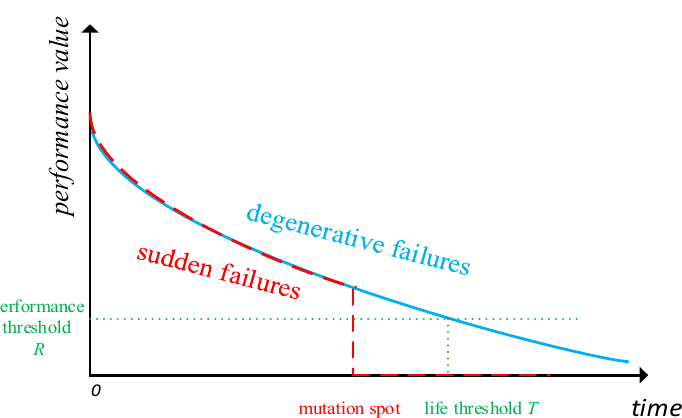
Figure 3. Performance change trends of sudden failures and degraded failures.